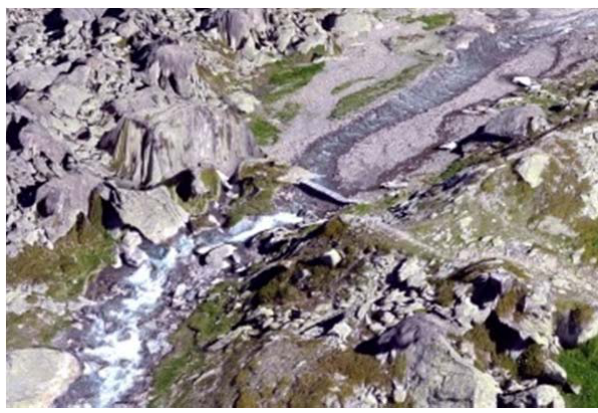
Figure 10: Section of the Combined DSM